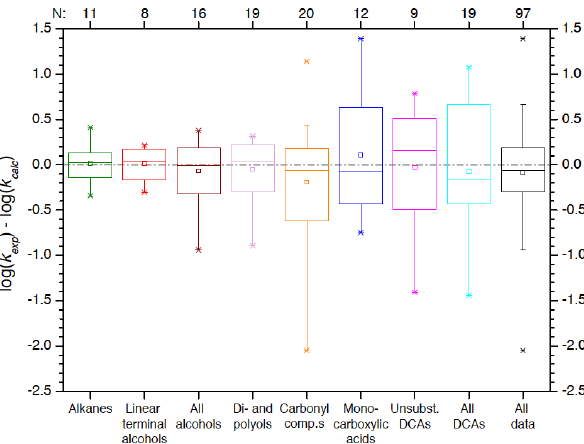
Figure 2. Box plots of the absolute errors of Evans–Polanyi-type correlations of hydroxyl radical reactions with organic compounds distinguished by compound